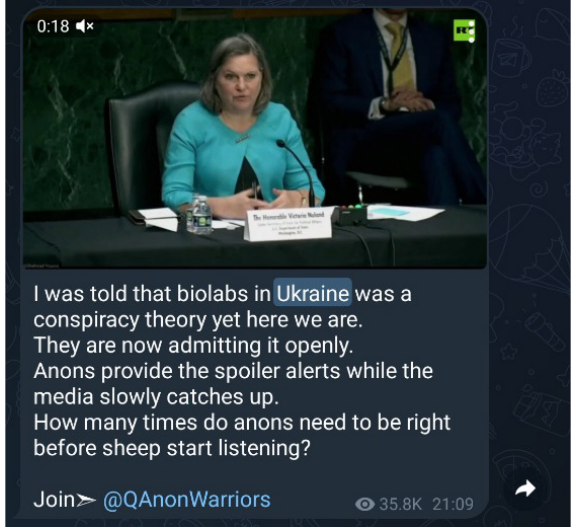
Figure 2. Victoria Nuland at US Senate